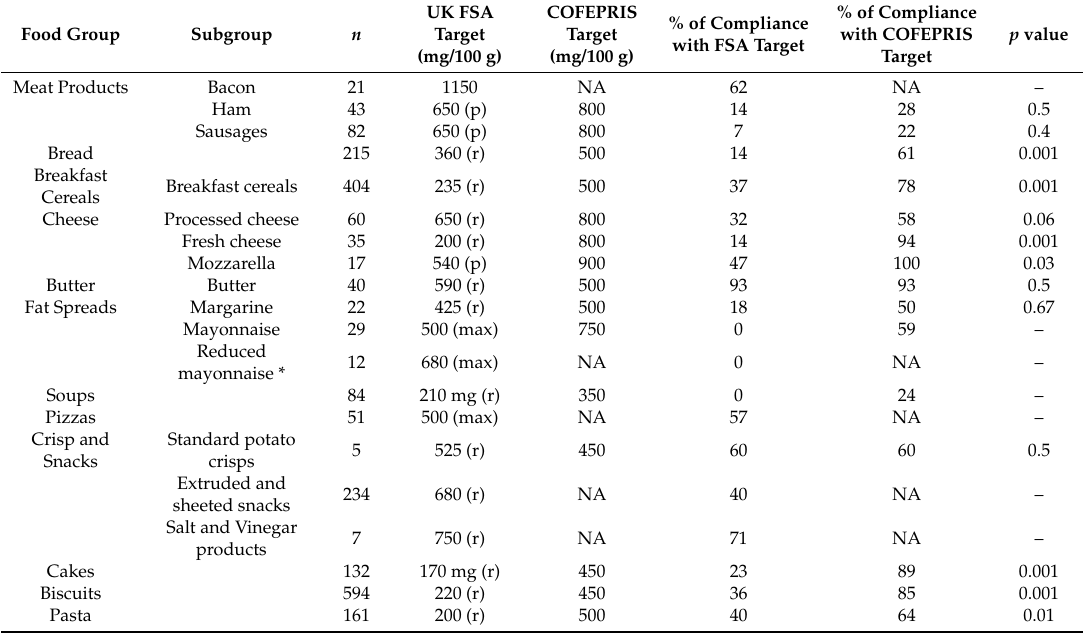
FSA targets: There are two types of averages used within the targets table. Average (p) used to account for ranges of salt levels that occur in a single product and average (r) which is used to account for a range of different flavors. * Reduced mayonnaise: Refers to those mayonnaises that have reduced fat or reduced